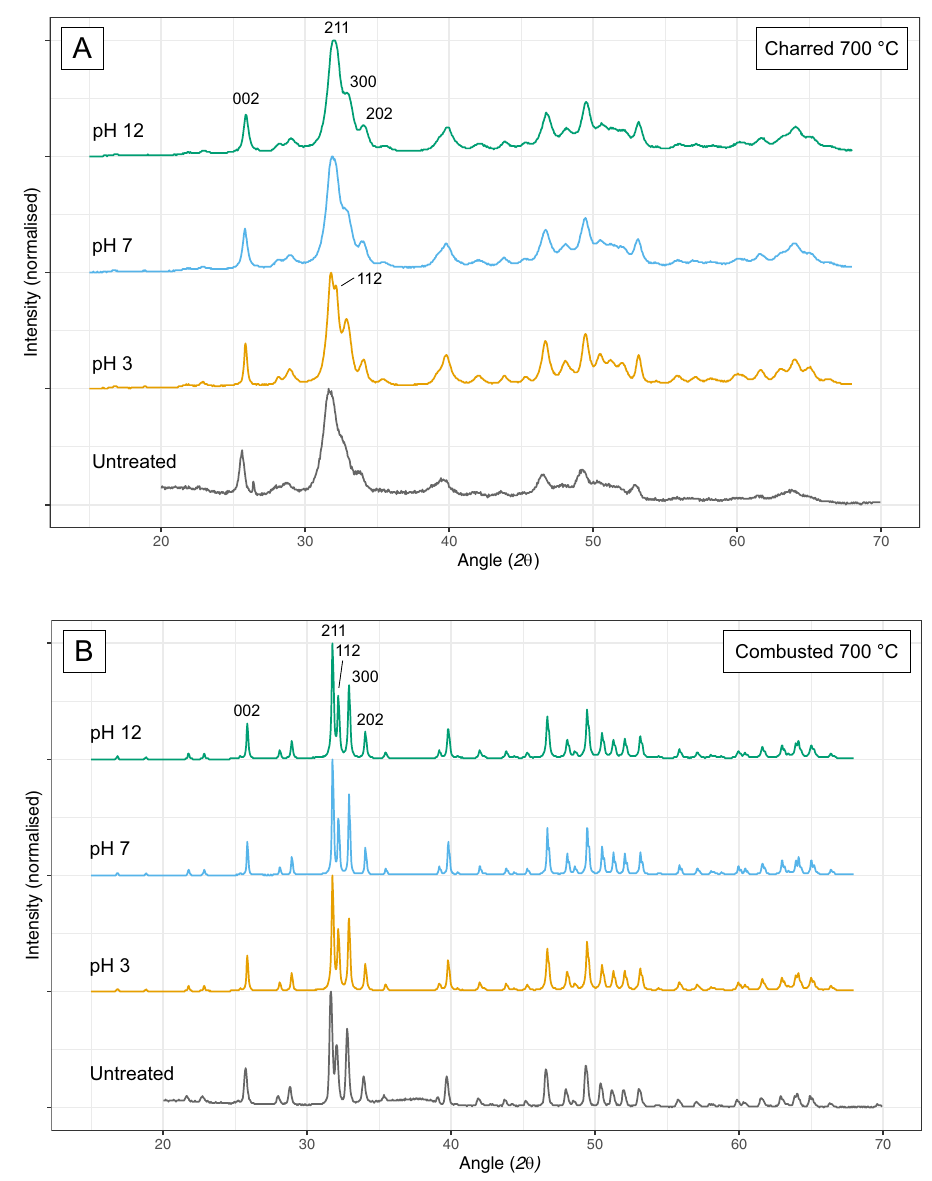
Figure 3. XRD diffractograms for samples charred ( A ) and combusted ( B ) to 700 °C, compared to their untreated equivalent. All notable peaks are labelled. Grey = untreated, yellow = pH 3, blue = pH 7, green = pH 12. For all other diffractograms see Supplementary Information Fig.